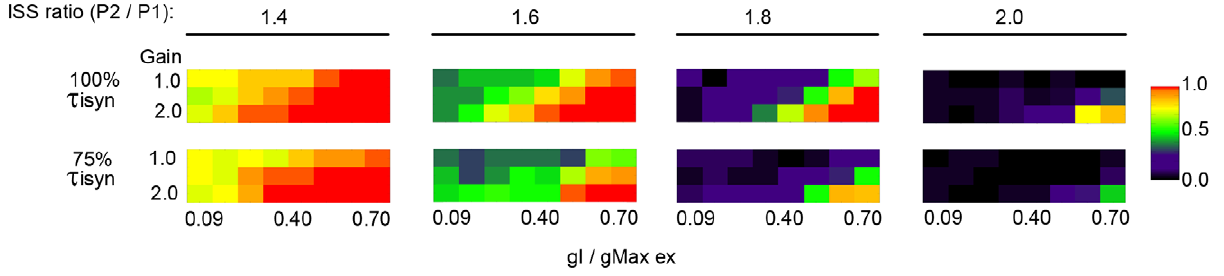
Figure 6. An increase in gain can compensate for the decrease in the decay time-constant of synaptic inhibition. The fraction of trials in which P1 out-competed P2 was diminished when the decay time-constant of synaptic inhibition ( t isyn ) was decreased to 75% of the original value of 5.75 ms. However, an increase in gain, implemented as an increase in number of inhibitory presynaptic spikes, increased the fraction of trials in which P1 out-competed